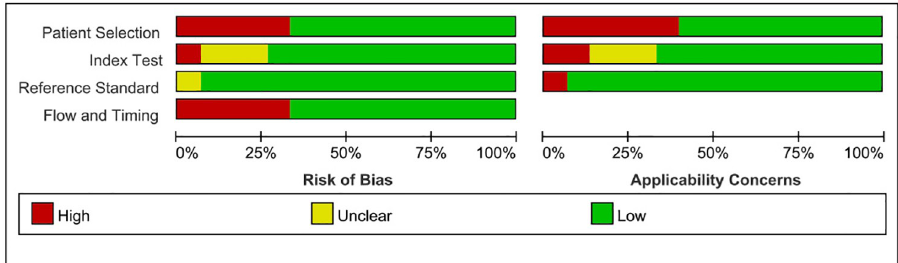
Effect of PET/CT on diagnosis The 14 eligible studies were pooled for the meta-analysis of diagnostic test. As moderate het- erogeneity among the 14 studies was observed ( I 2 = 68, 95% CI: 28–100). Fig 3 shows the forest plots of sensitivity, ranging from 0.25 to 1.00 (pooled 0.71; 95% CI: 0.54–0.83), and specificity, ranging from 0.77 to 1.00 (pooled 0.97; 95% CI: 0.93–0.98). The pooled positive-likelihood ratio (PLR) was 21.53, and the pooled negative-likelihood ratio (NLR) was0.30 (Fig 4). Fig 5 shows the diagnostic odds ratio (DOR) ranging from 5.00 to 2139.00 (pooled 70.59; 95% CI: 23.61–211.07). The area under the curve (AUC) for PET/CT was 0.95 (0.93–0.97).